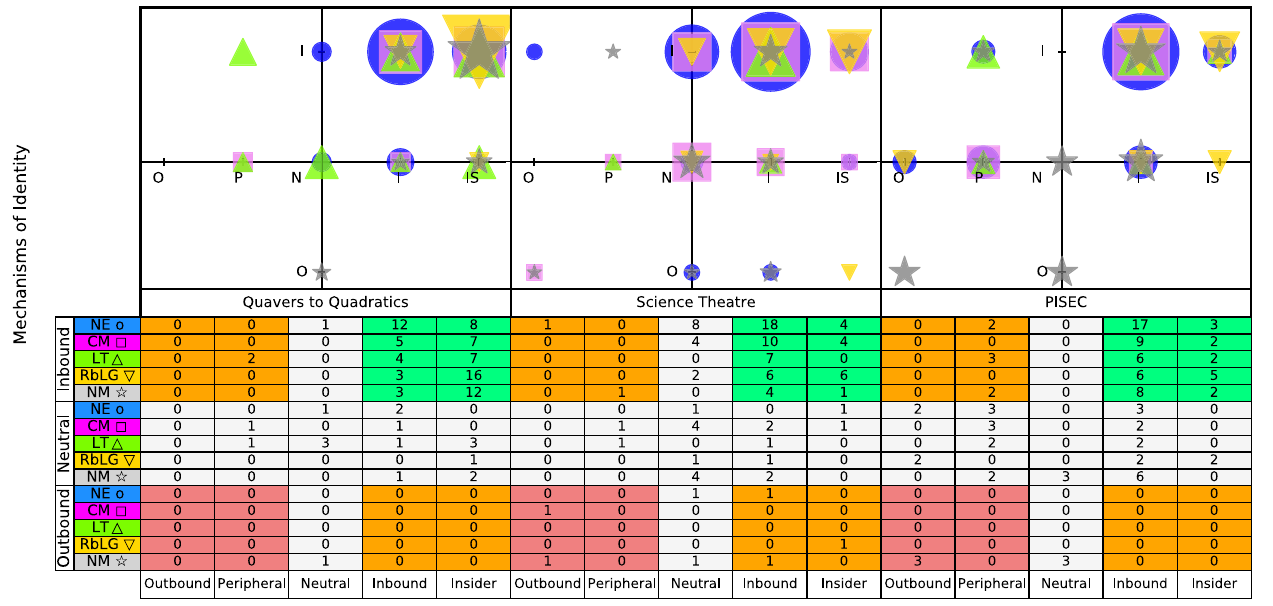
FIG. 4. The intersection of the accountability to the enterprise — community dimension subcodes ( x axis) with all five of the mechanisms of identity and their subcodes ( y axis). Each mechanism is represented by a different color and shape as shown in the second column of the table. The frequencies of the overlaps are shown by the size of the shape and the exact percentage in the table below which follows the same layout as the graph with the four quadrants colored (green: inbound or insider with inbound, orange inbound or insider with outbound or outbound or peripheral with inbound, red: outbound or peripheral with